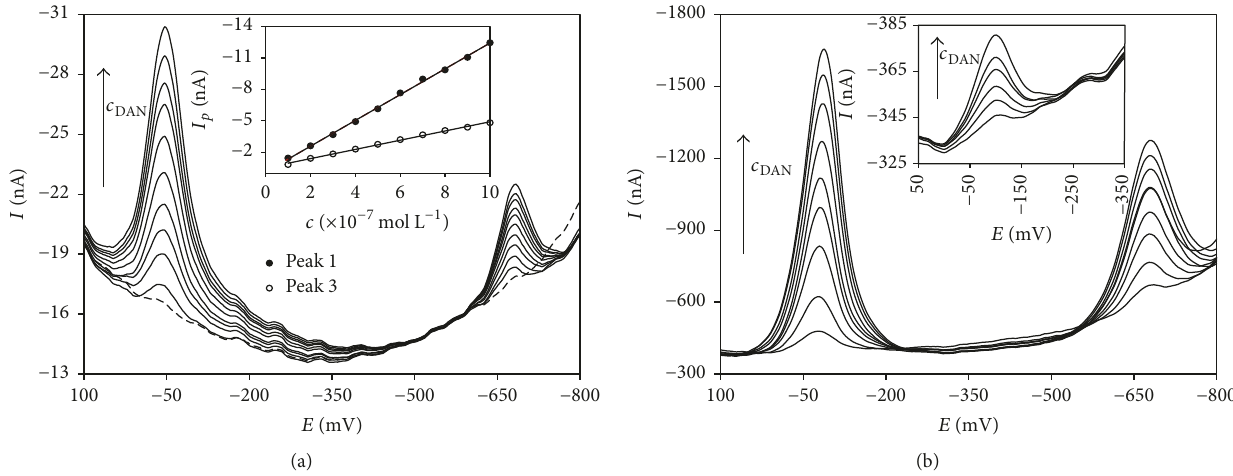
Figure 7: DP voltammograms of DAN in dependence on 𝑐 obtained on m-AgSAE (a) and BiFE (b). DPAdSV (a) and DPV (b); electrolyte: DAN BRB (pH 6.0 (a) and 5.0 (b)); 𝐸 in = +200mV; 𝐸 fin = − 1100mV; V = 40 mVs −1 ; pulse height = − 60 mV (a) and − 50 mV (b); pulse width = 40ms (a) and 60 ms (b); 𝐸 = +200mV; 𝑡 = 20 s (a) and 0.0s (b); 𝑐 = 1.0 × 10 −7 –1.0 × 10 −6 mol L −1 (a) and 1.0 × 10 −6 –9.0 × 10 −6 molL −1 (b). acc acc DAN Inset (a) : dependence of 𝐼 𝑝 on 𝑐 (m-AgSAE) for both DAN signals. Inset (b) : DP voltammograms of DAN in dependence on 𝑐 DAN